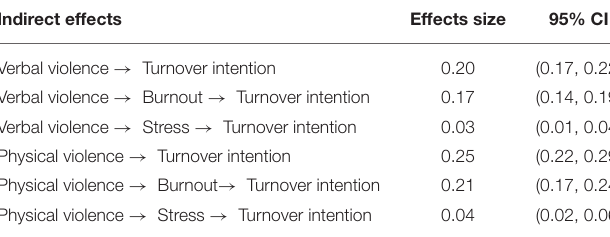
TABLE 4 | Mediation analysis of indirect effects of burnout and